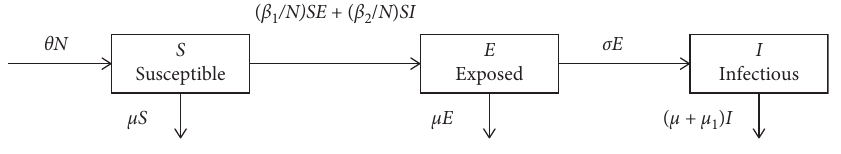
Figure 1: Transfer diagram of the SEI epidemic process.